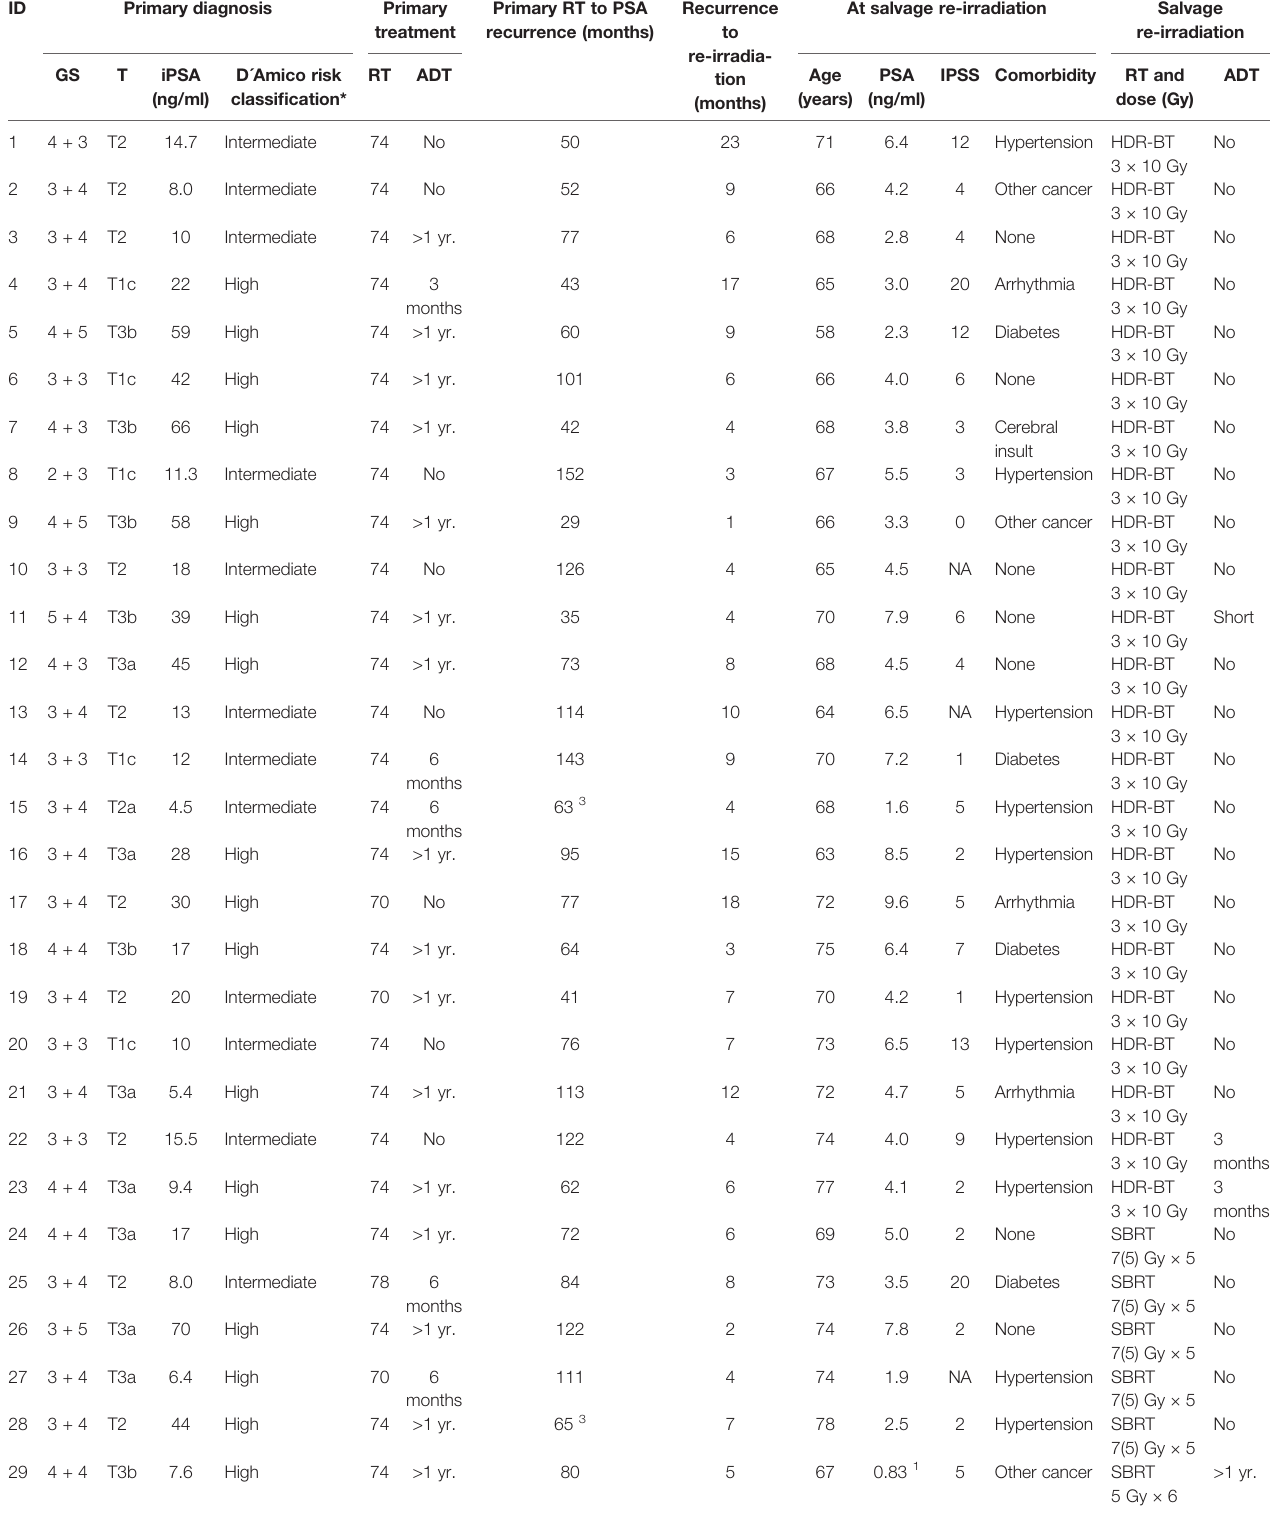
TABLE 1 | Detailed overview of patient characteristics and